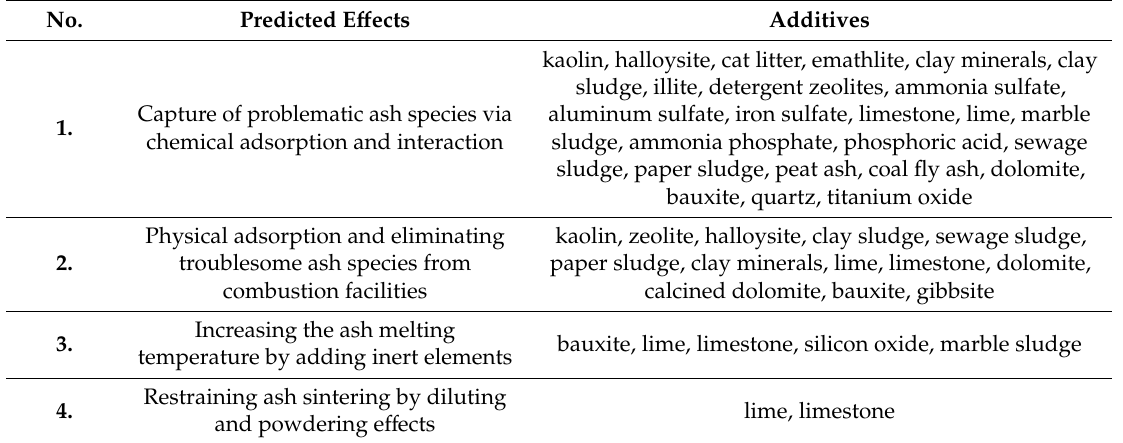
Table 2. Overview of additives application [10].